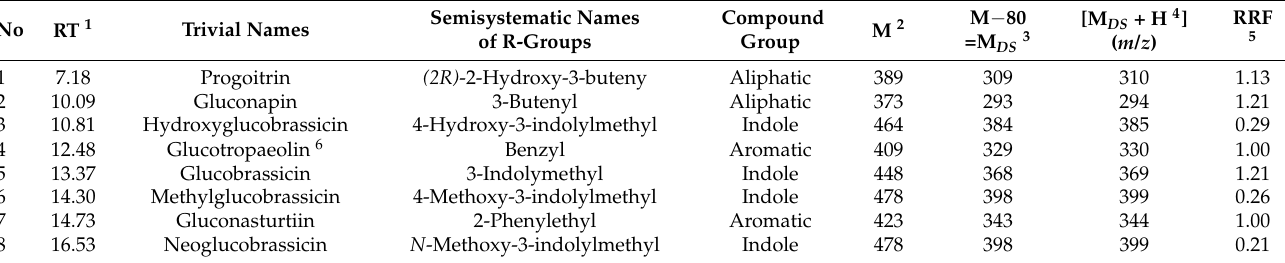
Table 3. Glucosinolates identified in “Red Russian” kale.